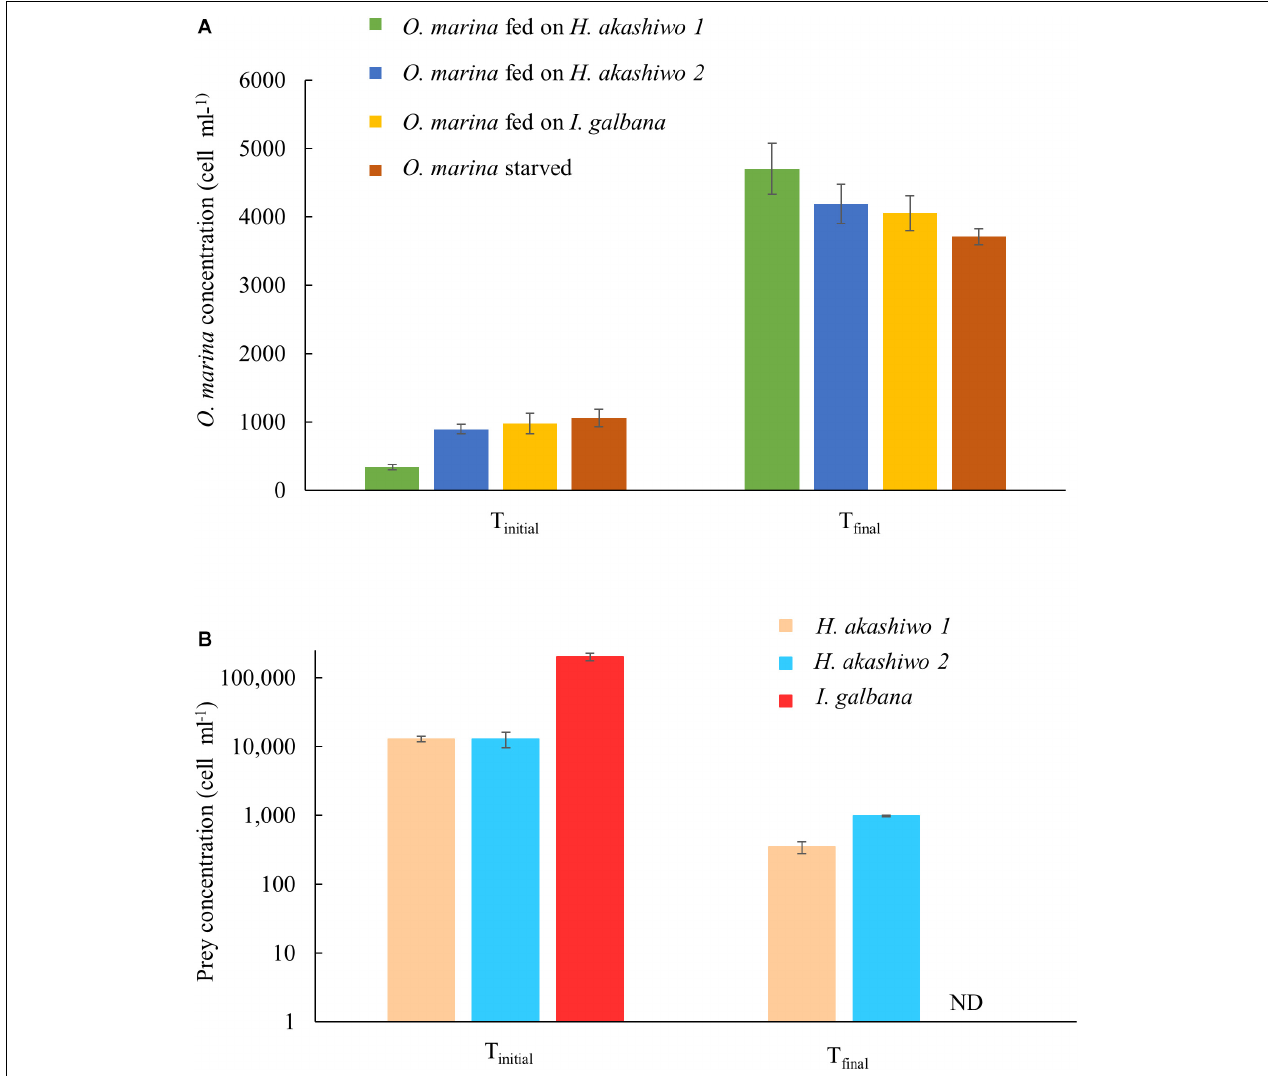
FIGURE 1 | Predator and prey cell concentrations at the start ( T initial ) and end ( T final ) of the experiment for the predator species O. marina (A) and the phytoplankton prey species: H. akashiwo strain 1, H. akashiwo strain 2, and I. galbana (B) . Cell harvests at T final occurred on day 3 for the fed treatments and day 7 for the starved treatment. ND indicates cell concentration below detection for I. galbana ( < 1 cell ml − 1